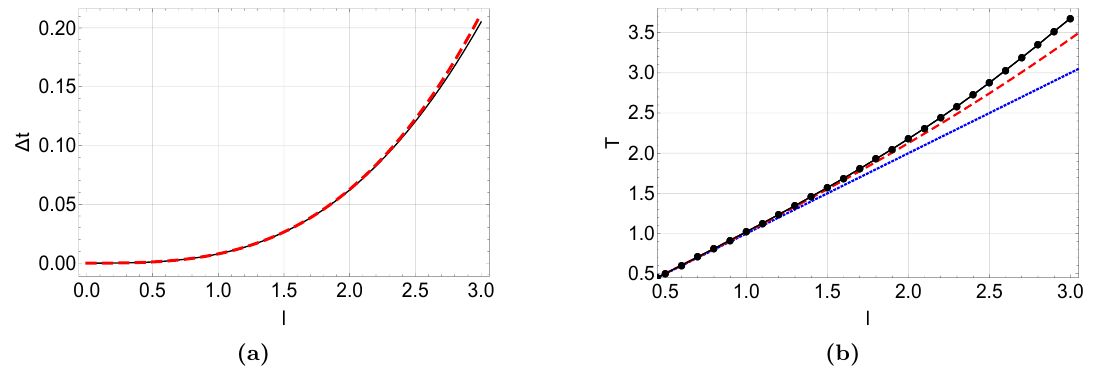
Figure 14. (a) The expression (cid:1) t , where the solid line is a numerical solution of (5.34) whereas the dashed line represents the expression (5.37). (b) The period of the oscillon T ( l ). The solid line with dots stands for result obtained from numerical simulation. The dashed line represents analytical expression (5.38). The dotted straight line stands for the period of the exact breather.